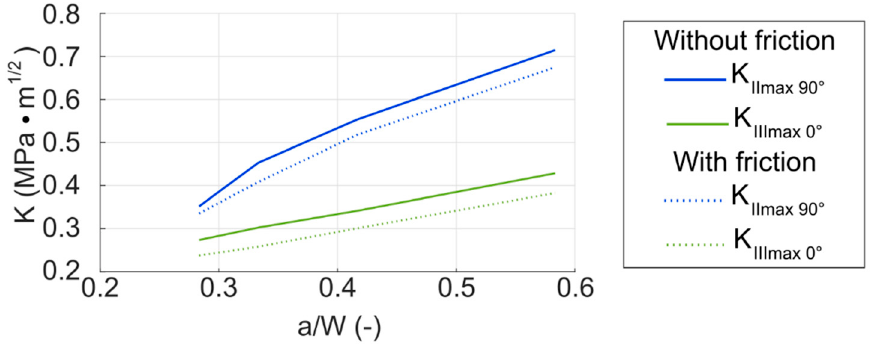
Figure 17. K IImax and K IIImax depending on the normalized crack length; comparison of model with void without friction and model with void with friction; void ratio h v / r v = 0.25, r v = 0.75 mm.